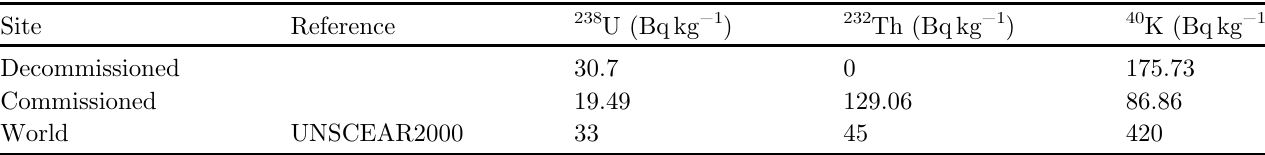
Table 3. Average activity concentration of the decommissioned and the commissioned site compared with the world averages (UNSCEAR